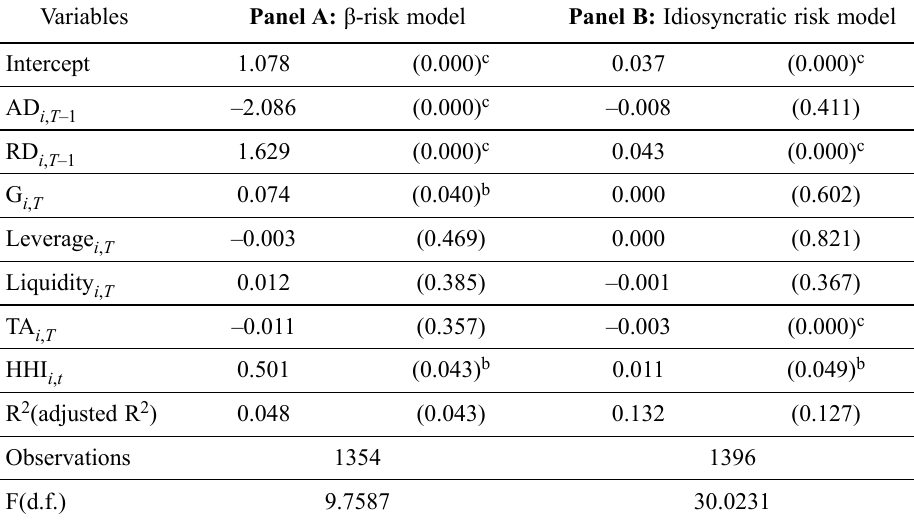
Table 3. Advertising, R&D and risks: results of